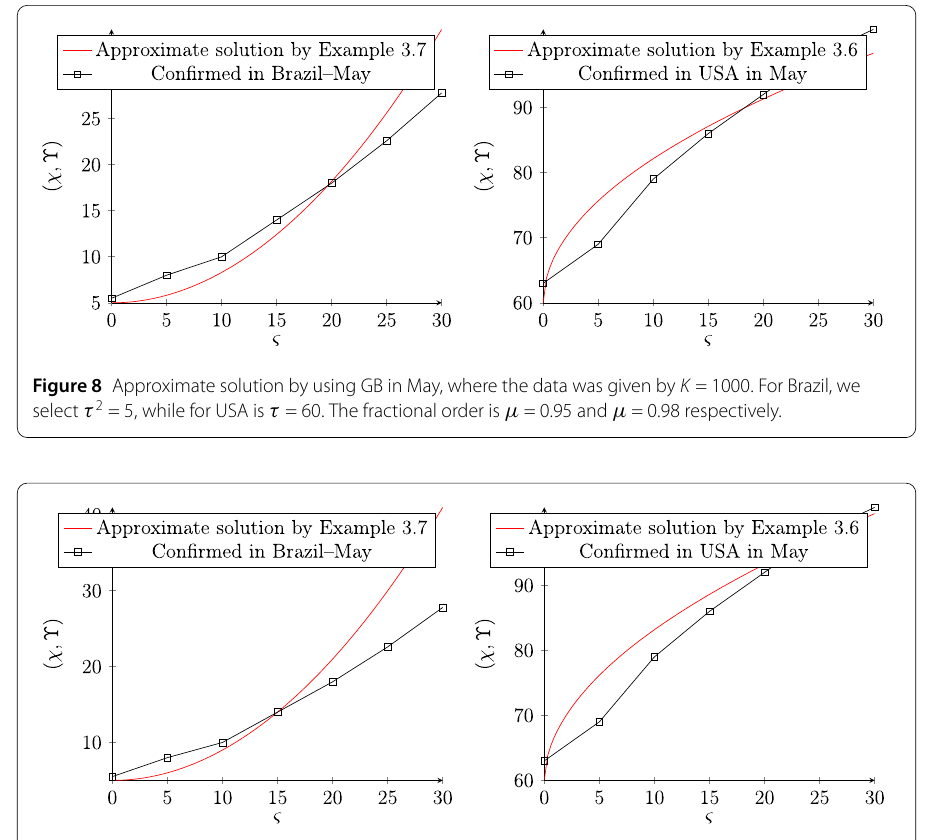
Figure 9 Approximate solution by using GB in May, where the data was given by K = 1000. For Brazil, we select τ 2 = 5, while for USA is τ = 60. The fractional order is μ = 1 and μ = 1